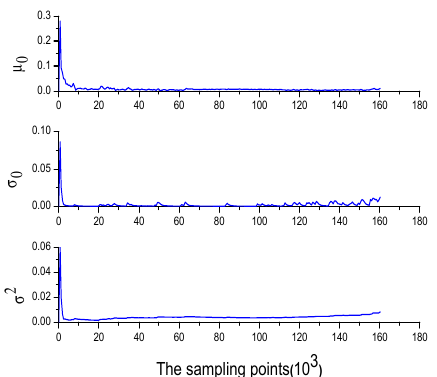
Figure 6. Adaptive estimation process of the model parameters.